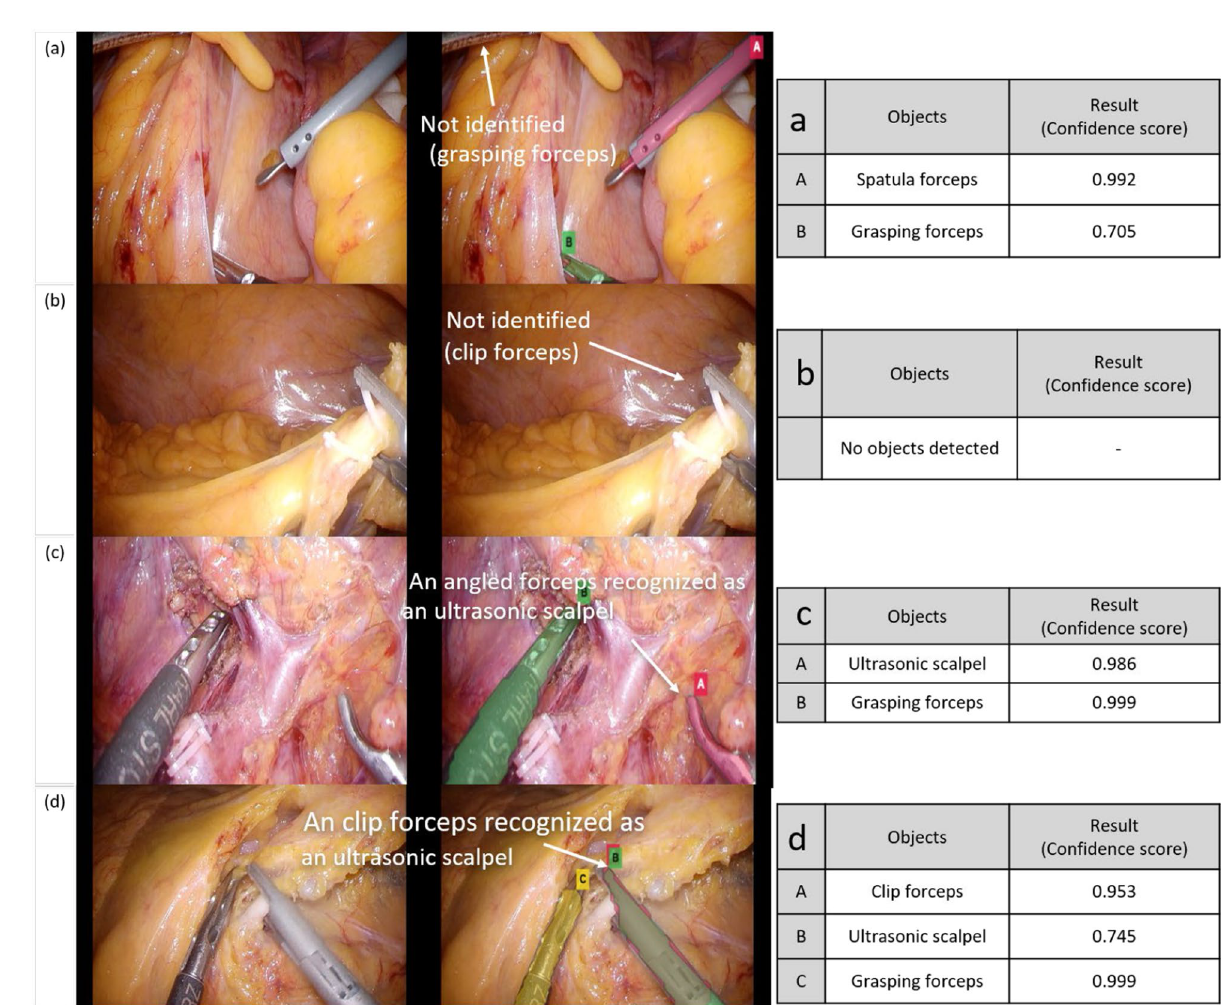
Figure 5. Representative images demonstrating inaccurate results. The images on the right side are original. The images in the middle are test results. The images on the right show the confidence scores of each result. ( a ) A grasping forceps and 1 spatula forceps were detected accurately, but 1 of the 2 grasping forceps in the image was not detected correctly; ( b ) the clip forceps was not identified correctly; ( c ) the angled forceps was recognized as an ultrasonic scalpel incorrectly; and ( d ) the clip forceps was identified correctly but was also recognized as an ultrasonic